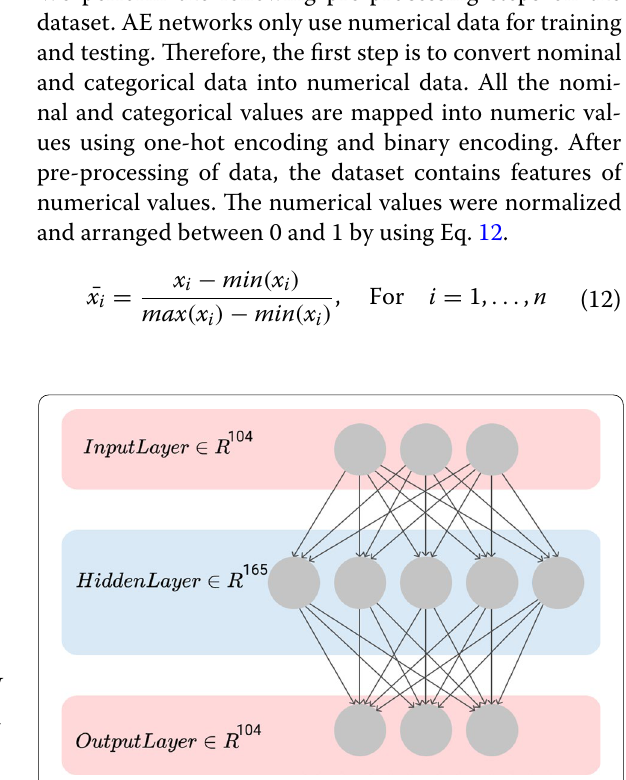
Fig. 7 The architectural diagram of AE model including the number of input, hidden and output